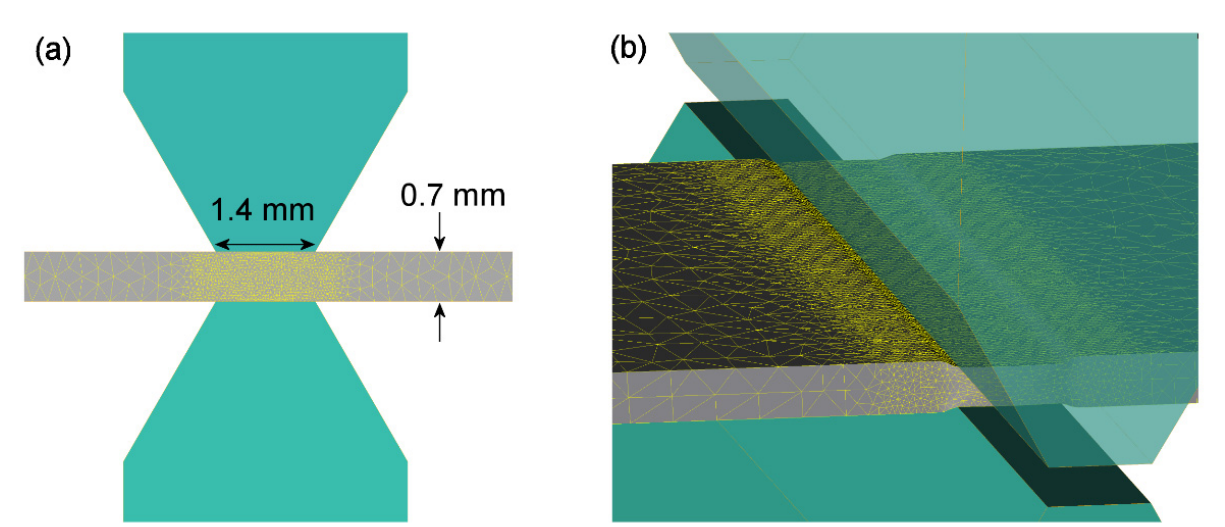
Figure 2. Geometry of tool and sample and mesh details in simulations considering ( a ) 2D and ( b ) 3D conditions.